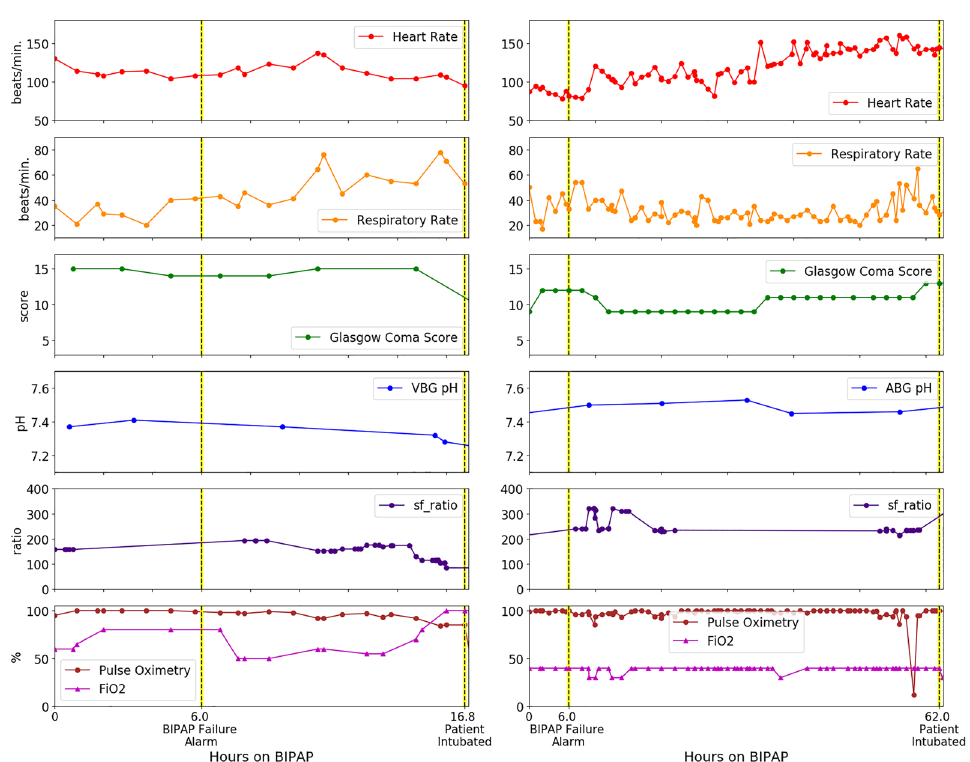
Figure 3. Examples of clinical utility of LSTM-RNN prediction in study patients. (Left) 16-year-old male with Acute Myelocytic Leukemia was admitted for septic shock and ARDS, intubated 17 h after BIPAP initiated. (Right) 3-year-old with hypoxic ischemic encephalopathy, epilepsy, metabolic alkalosis, and malnutrition admitted for respiratory failure, intubated 62 h after BIPAP initiation. In both cases, LSTM-RNN model predicted BIPAP failure at 6-h mark using the threshold of NNA =